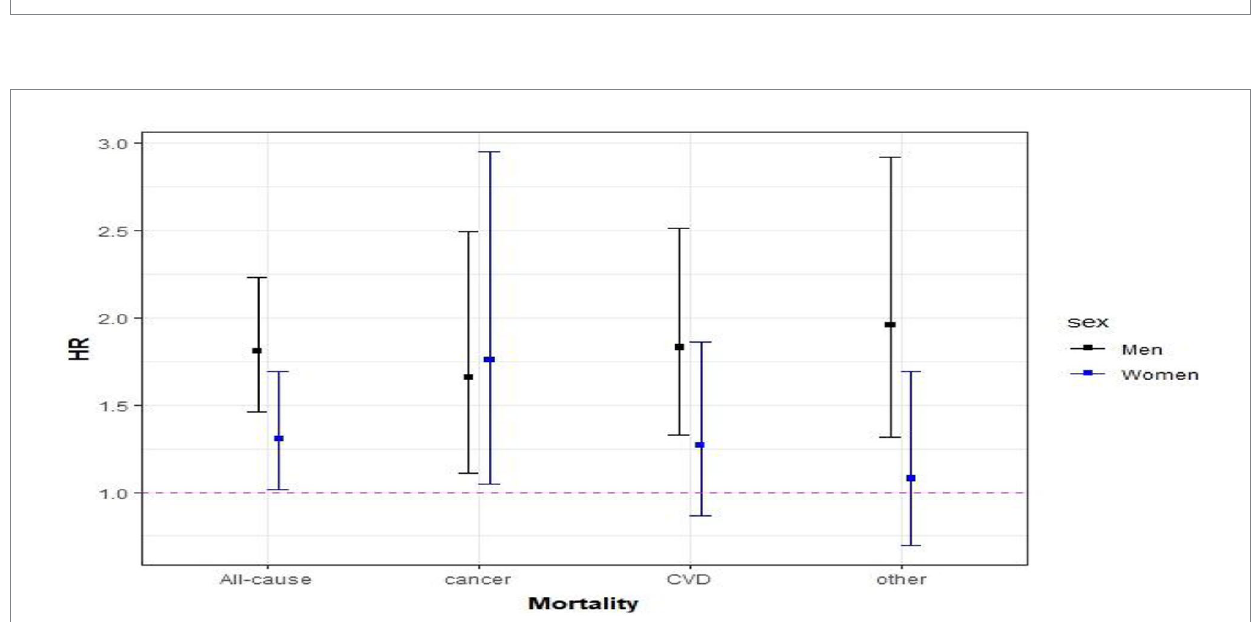
FIGURE 4 Association between BMI (kg/m 2 ) and all-cause mortality in men and women. Hazard ratios of all-cause mortality are calculated by the spline Cox proportional hazard model. Solid lines and dash lines, respectively, represent the hazard ratios and their 95% confidence intervals after adjusting for MM, age, education, family status, smoking habit, alcohol use, and physical activity.